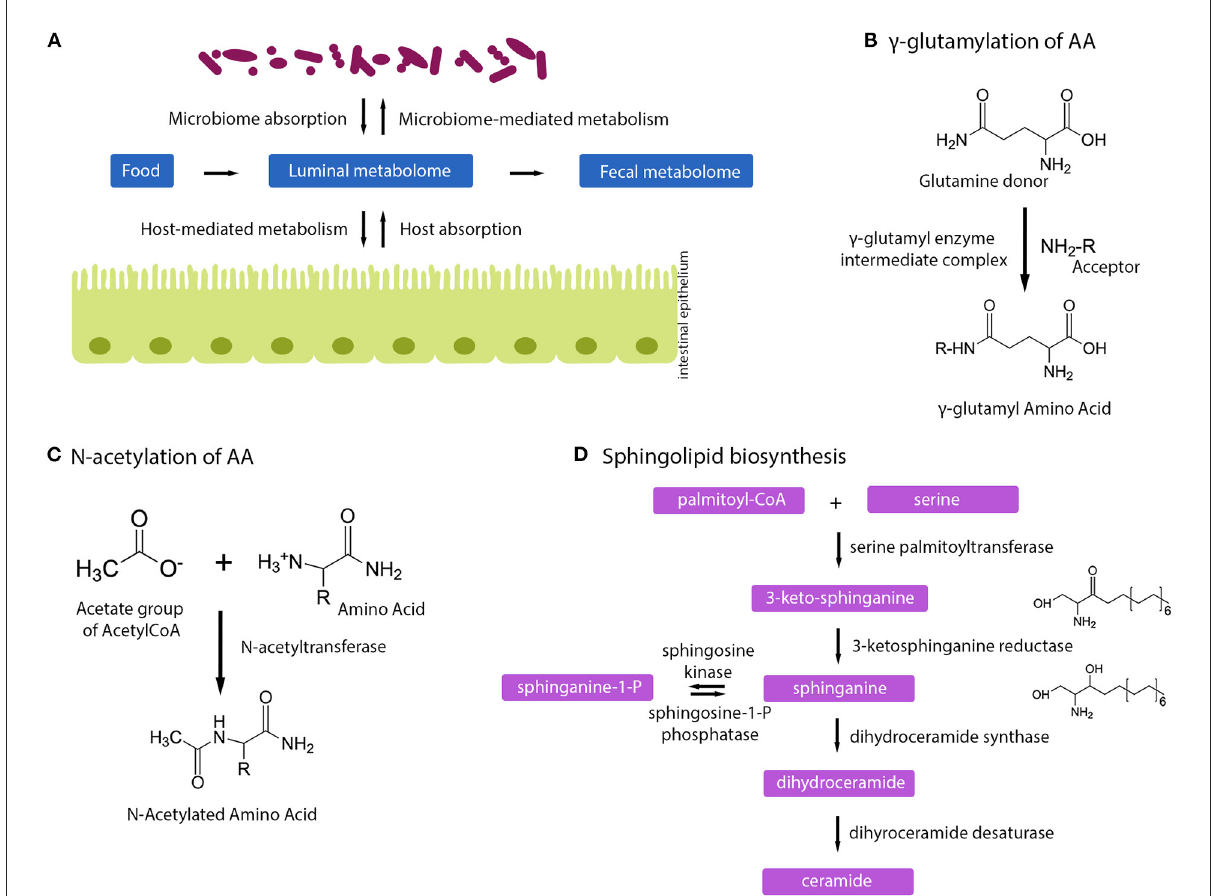
FIGURE4 Human milk oligosaccharides influence host–microbe metabolome. (A) Schematic of how microbiome, host, and fecal metabolome can impact each other. (B) Gamma-glutamylation of amino acids happens via a gamma-glutamyl intermediate complex. (C) Mechanism of N -acetylation of amino acids. (D) Sphingolipid biosynthesis